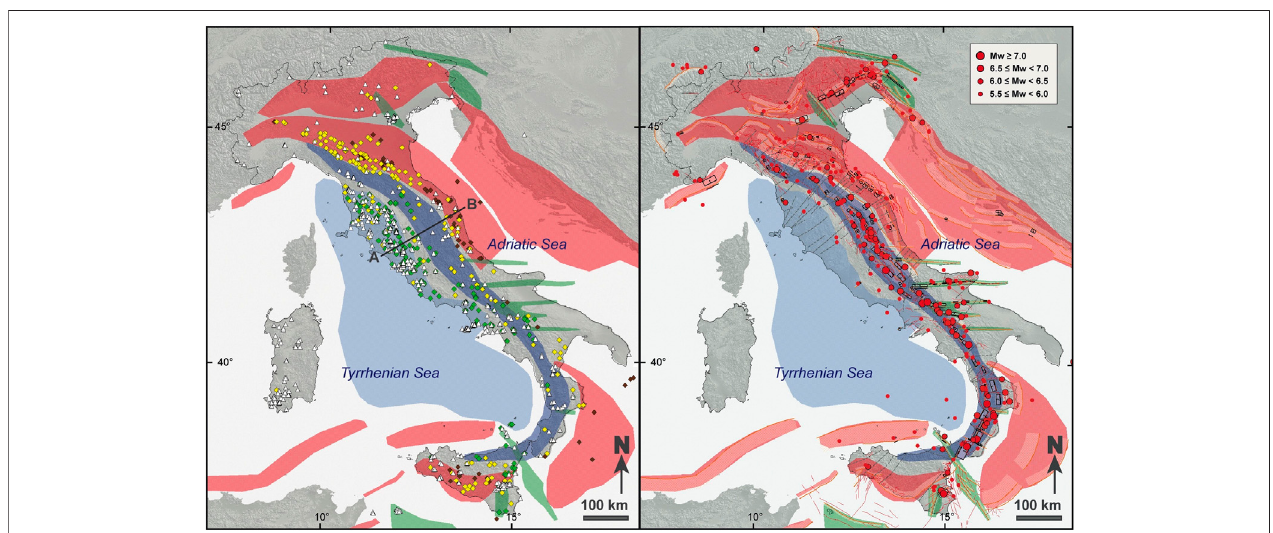
FIGURE2| Studyareaandsummaryofdatausedinthiswork.Inboth fi gurestheshadedareasindicateactivetectonicdomains.Key:lightblue,areasofriftingand mantle upwelling; blue, post-orogenic extension; red, active contraction; green, active strike-slip. Left: Geo fl uid emissions. Key: white triangles, thermal springs having T > 20 ° C; green diamonds, natural CO 2 emissions; yellow diamonds, gas seeps; brown diamonds, mud volcanoes. A-B: trace of the topographic pro fi le of Figure 14 . Right: Seismological and tectonic information. Key: black boxes and red ribbons, surface projection of Individual and Composite Seismogenic Sources, respectively (ISSs and CSSs) from the DISS 3.2.1 database; red lines, capable faults from the ITHACA database; black dashed lines, transverse lineaments from the DISS 2.0 database; red symbols, earthquakes of M w 5.5 and larger from the CPTI15 catalogue.